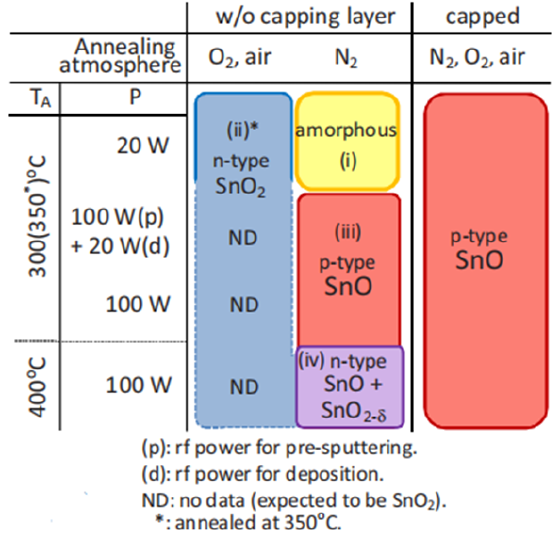
Figure 10: Schematic phase classification of SnO-SnO 2 films de- posited with different sputtering, annealing and capping condi- tions